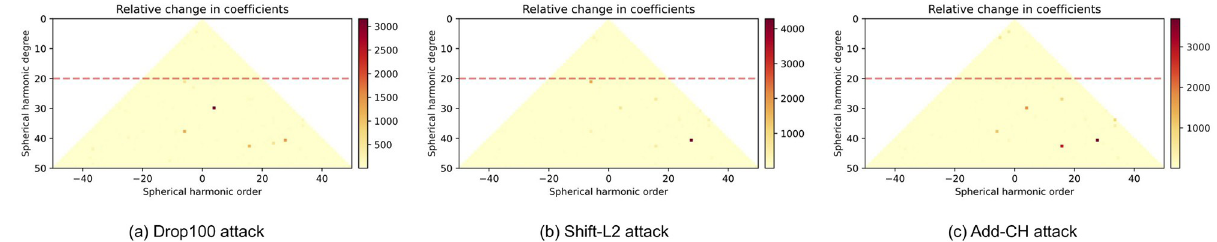
Fig 4. Spherical harmonic coefficients for different adversarial perturbations on ModelNet40. Upper vertex and two lower vertices of the triangle represent the lowest and highest frequency components in the frequency space. Results show that more remarkable changes occur in mid- and high- frequency ranges. [Lighter color reveals a more remarkable change for a particular frequency component between original point clouds and adversarial one.].